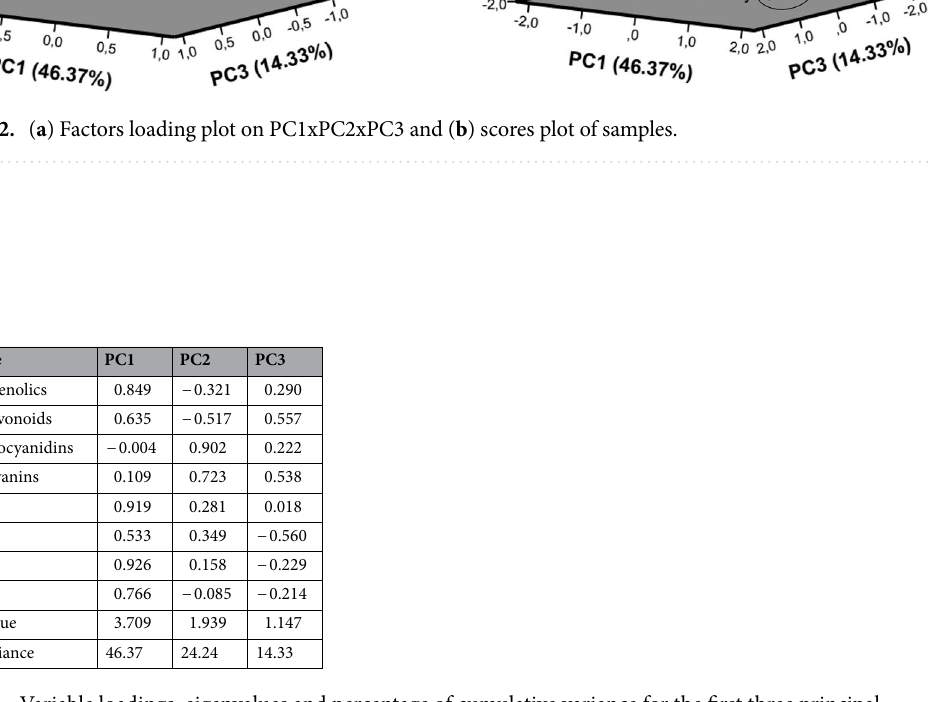
Table 4. Variable loadings, eigenvalues and percentage of cumulative variance for the first three principal components